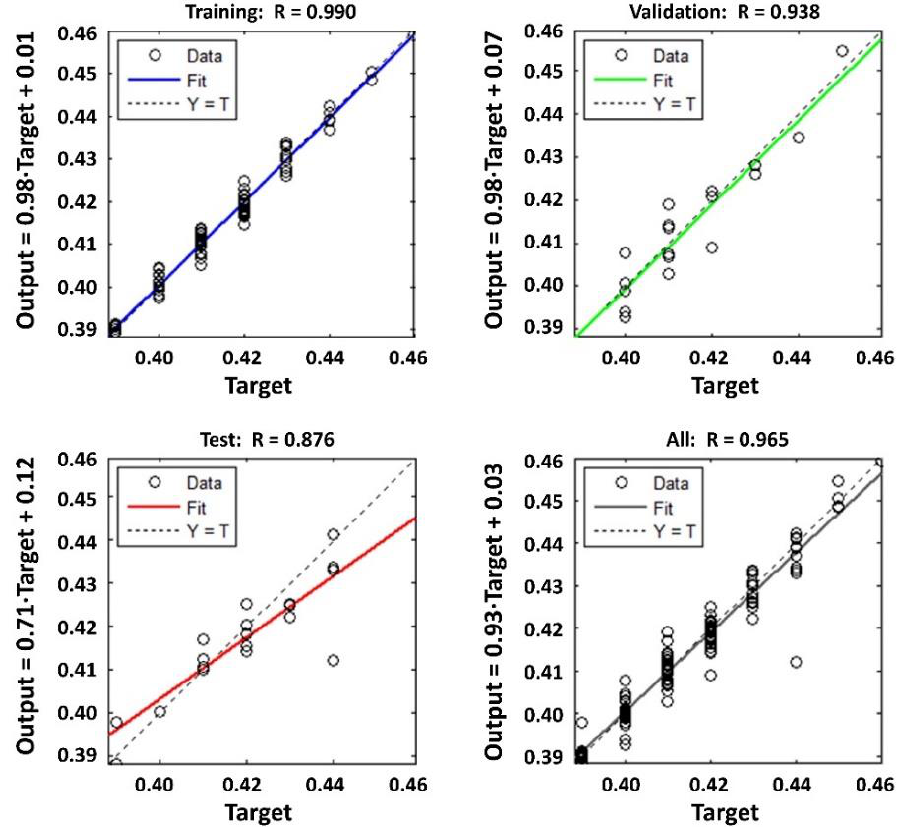
Figure 5. Regression plots.